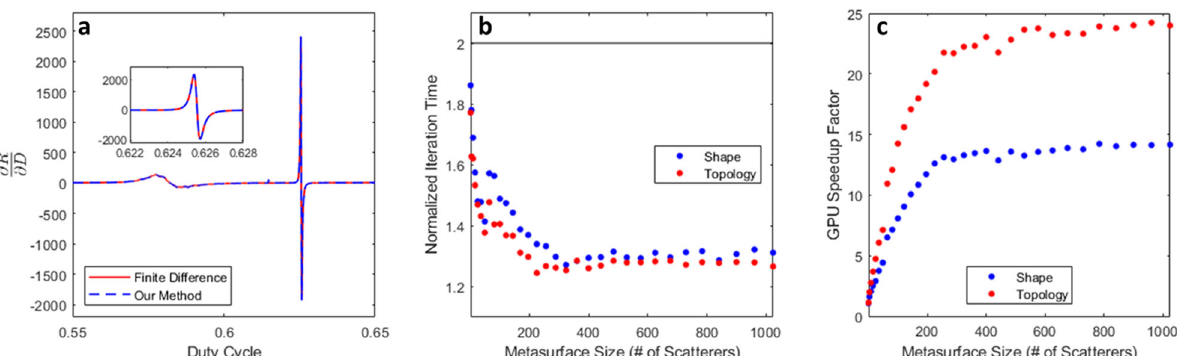
Fig. 2 Evaluating gradients and iteration time. a Our method of computing the partial derivative of the re fl ectance R with respect to the duty cycle D (i.e., the diameter to pitch ratio) of a cylindrical nanopost TiO 2 grating agrees well with the results of the fi nite difference method, even on resonance (zoomed in the inset). b For both topology and shape optimizations, our method represents a marked speedup in iteration time relative to the time for a respective forward run owing to our reuse of the costly eigendecomposition step from the forward pass during gradient calculation. In both cases, our method achieves normalized iteration times less than those typical of the adjoint method, denoted by the black horizontal line at twice the forward simulation time. c Our framework is amenable to GPU acceleration, enabling signi fi cant reductions in computation time compared to running the same optimization on a CPU. As the number of scatterers simulated increases, the speedup factor eventually saturates, with topology optimizations typically obtaining a greater bene fi t from a GPU. In both ( a ) and ( b ), the points shown are mean values, the errors for which are omitted from the plot as they are smaller than the symbol size.